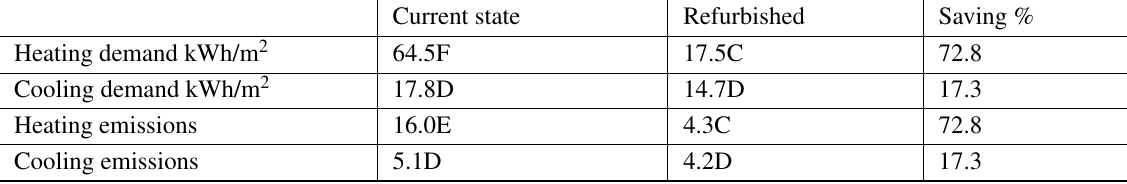
Table 4. Improvement of energy performance and savings in emissions obtained by the CE3x